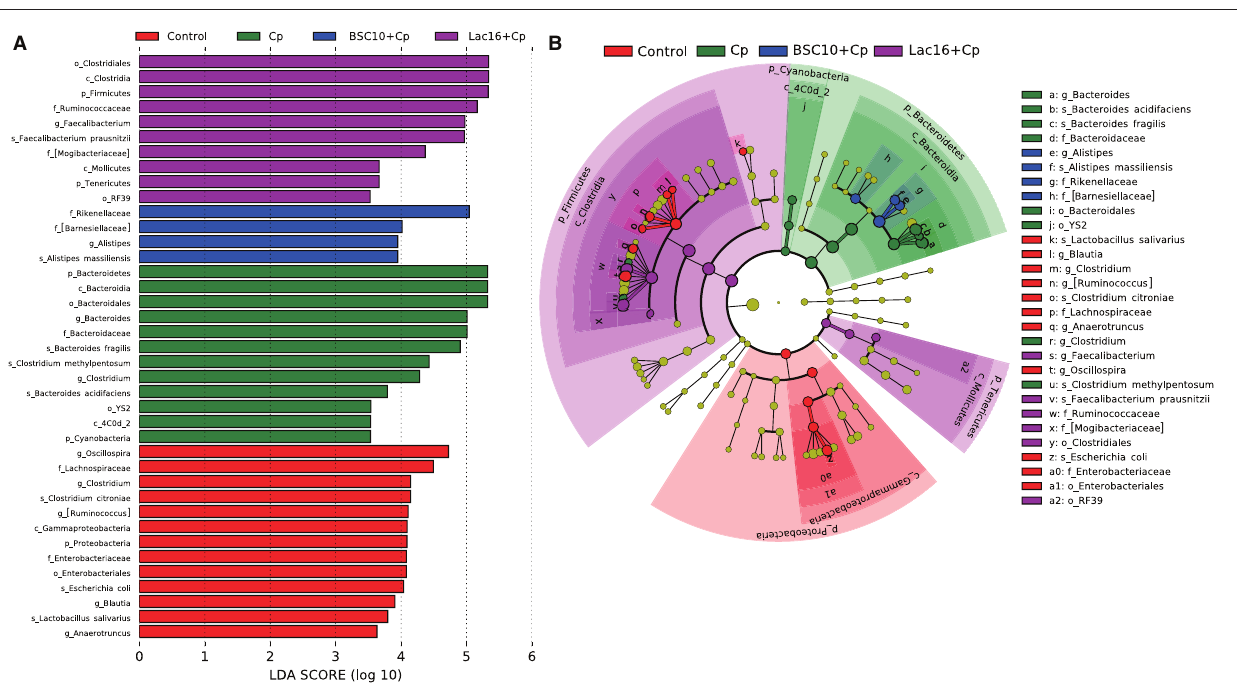
thiamine metabolism, histidine metabolism, and cell division ( Figure 8 and Supplementary Figure 2 ). Dietary with P. polymyxa had less effects on microbial metabolic functions than L. plantarum in C. perfringens -infected broilers ( Figure 8 and Supplementary Figure 2